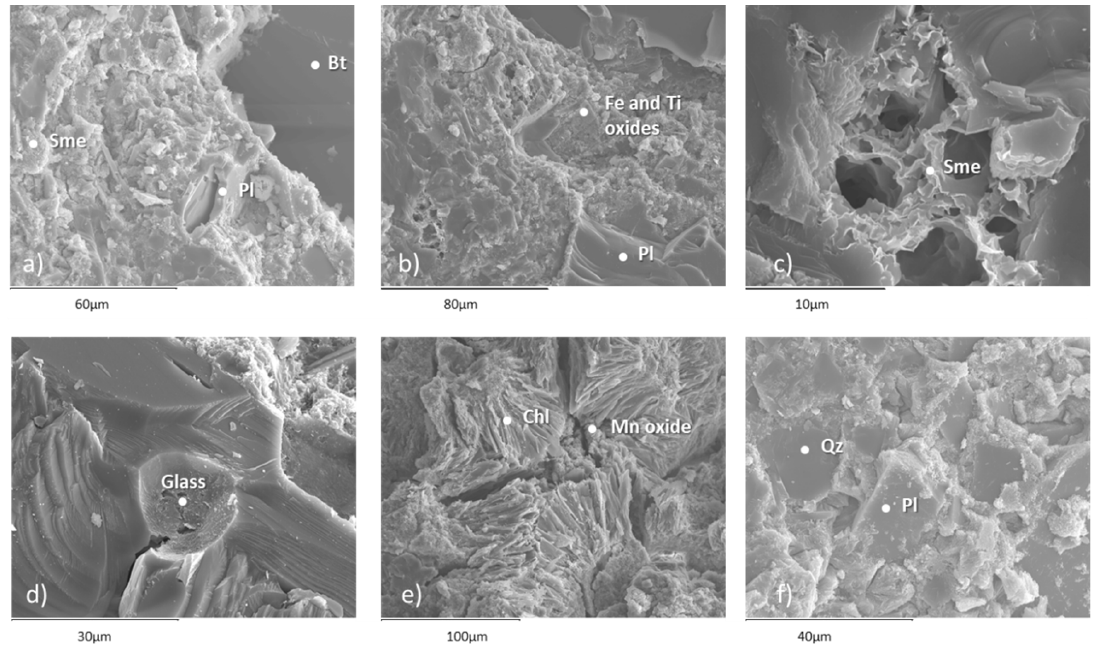
Figure 3. Microphotographs ( a – f ) obtained by scanning electron microscopy of secondary electrons.